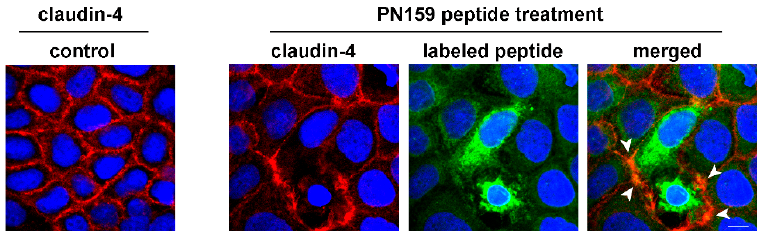
Figure 8. Caco-2 cells were treated with Bodipy FL labeled PN159 peptide (5 min), then fluorescent immunostaining of junctional protein claudin-4 and staining of cell nuclei were performed. Red color: immunostaining for claudin-4. Green color: Bodipy FL labeled PN159 peptide. Blue color: staining of cell nuclei by H33342. Bar = 10 μ m. Arrowheads indicate co-localization of claudin-4 and the labeled PN159 peptide.